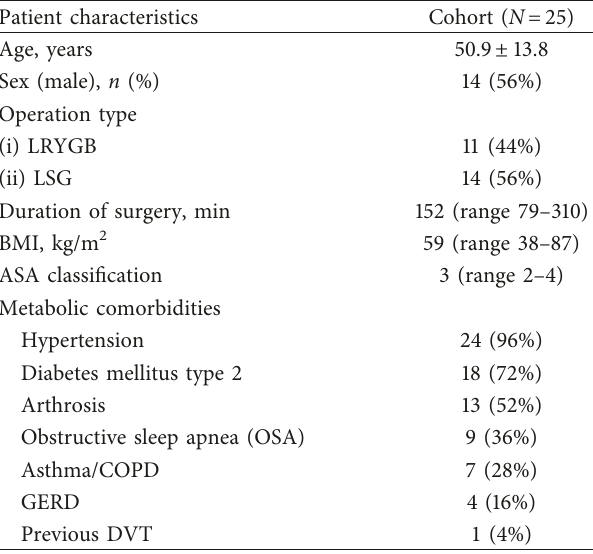
Figure 1: The number of patients in each high-risk subgroup Table 2: Baseline of study cohort.